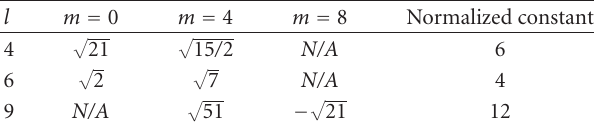
Table 2: The coe ffi cients of the OSAF for l =